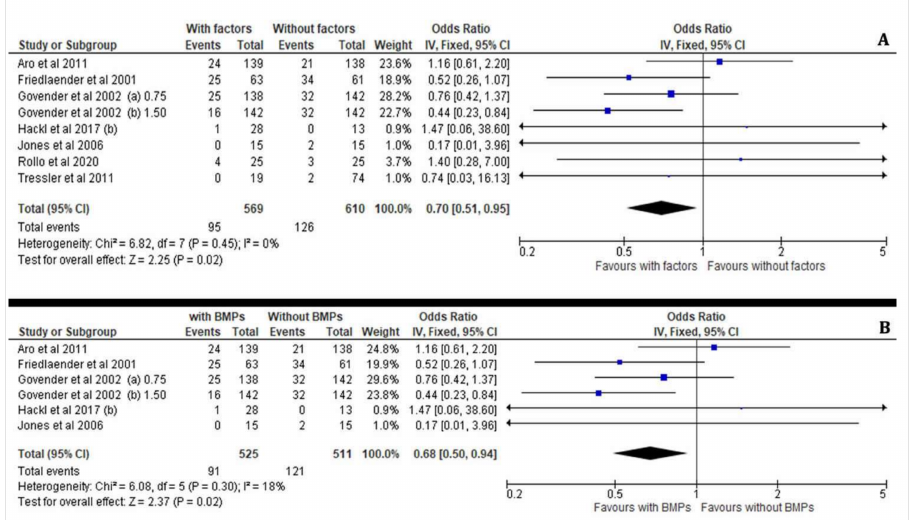
Figure 9. Forest plots showing the overall incidence of hardware failure after the application of osteoinductive factors ( A ) and after the use of BMPs only ( B ) compared with the non-treated (control) groups [23,29,32,33,35–37].